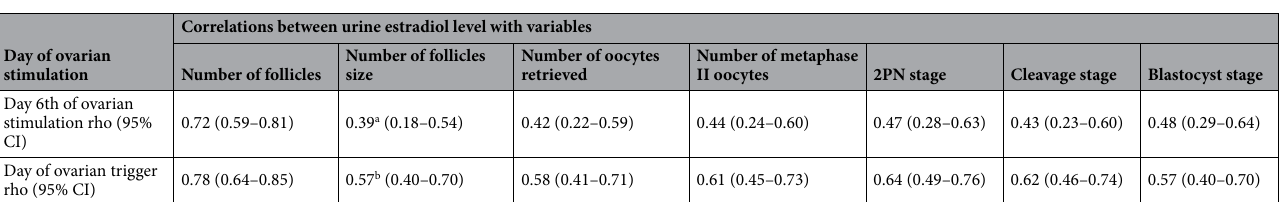
Table 3. Spearman’s correlation coefficients for urine estradiol level in the infertility treatment outcomes. PN pronuclei. a Correlation between urine E2 and Number of follicles size ≥ 10. b Correlation between urine E2 and Number of follicles size ≥